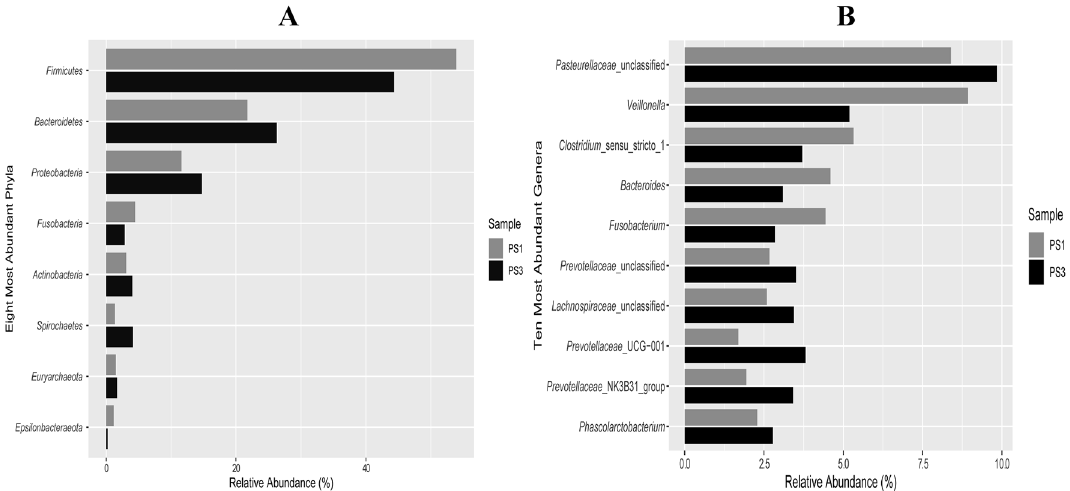
Figure 2. Most abundant microbial phyla ( A ) and genera ( B ) in vaginal swabs from sows with low and high risk for pelivc organ prolapse (POP). ( A ) Vaginal swabs were collected from sows with low (PS1) and high (PS3) risk for POP and microbial detection and abundance were determined through 16 s rRNA sequencing and analysis. Spirochaetes abundance between PS1 and PS3 sows was significantly different ( P < 0.05). ( B ) Stacked bar charts comparing the ten most abundant vaginal microbial genera. Relative abundance of vaginal swab microbial communities on a genus level represent the mean across each perineal score. Animals assumed low risk for POP are considered PS1 and high risk animals for POP are considered PS3.